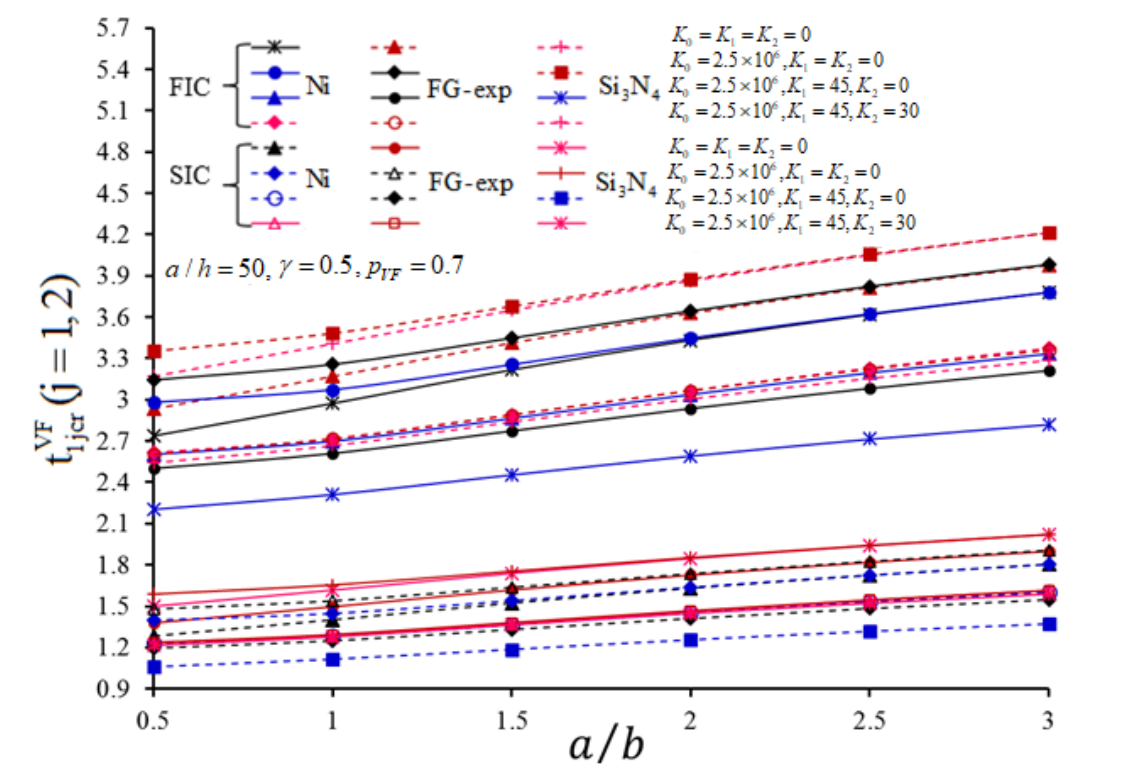
Figure 7. Distributions of critical times of FG-VE-Ps on VE-Fs versus a / b with FIC and SIC for various VE-Fs.